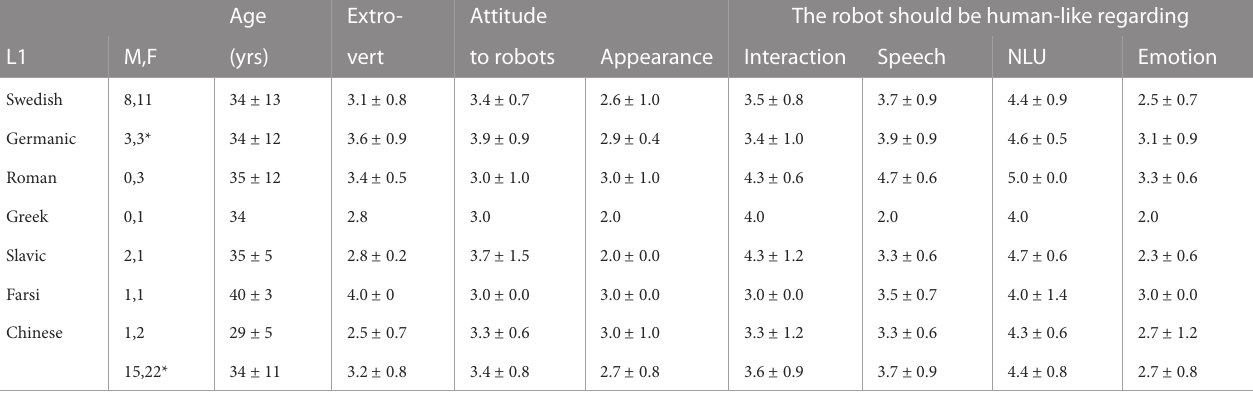
TABLE1 Summaryofdemographicdetailsandpre-sessionanswers.L1groupsareexplainedinthemaintext.M,FindicatethenumberofMaleandFemale subjects(*=+1non-binary).Extroversion,Attitudetowardsinteractingwithrobotsandratingsofhowhuman-liketherobotshouldbewhenitcomesto